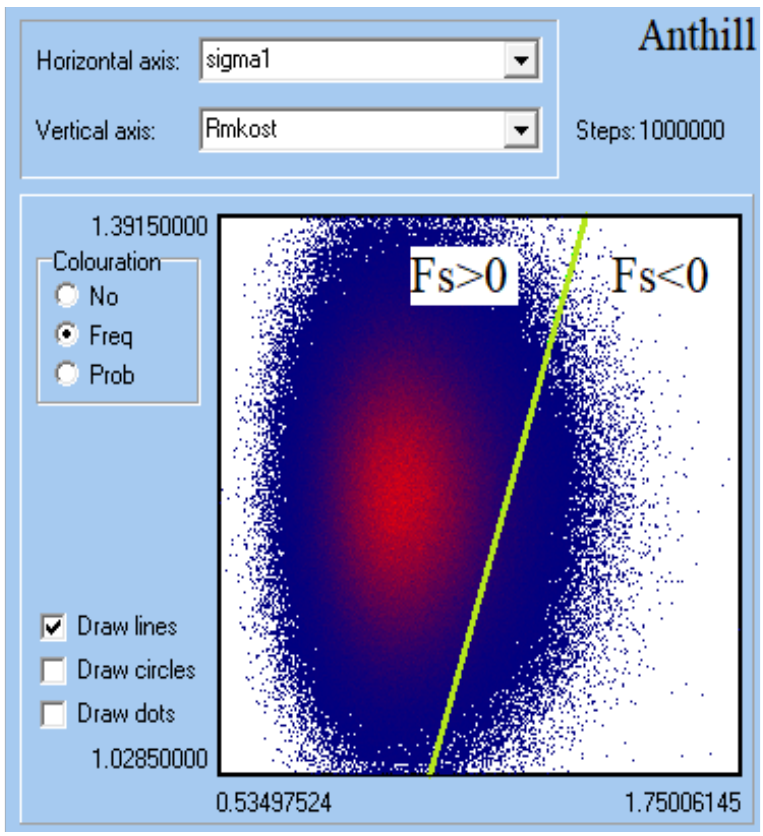
Figure 10. Two-dimensional distribution of the reliability function values (horizontal axis represents calculated stress and vertical axis is yield stress, steps: 1,000,000) — Anthill software.